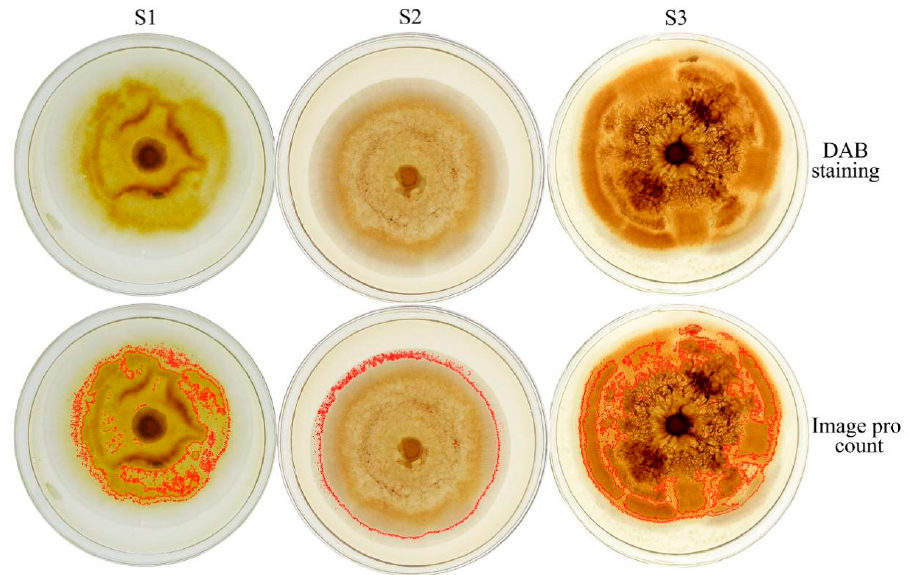
Figure 3. DAB staining photos of colony hydrogen peroxide. The upper row shoot in back light, the lower row is the Image-Pro software count picture. S1 group ( n = 3): inoculation of F. solani on normal PDA; S2 group ( n = 3): inoculation of F. solani on PDA containing 40 µmol/L DPI; S3 group ( n = 3): inoculation of F. solani on PDA containing 40 µmol/L DPI. On the fourth day of cultivation, 5 mL of 0.0012% H 2 O 2 was added to each dish.